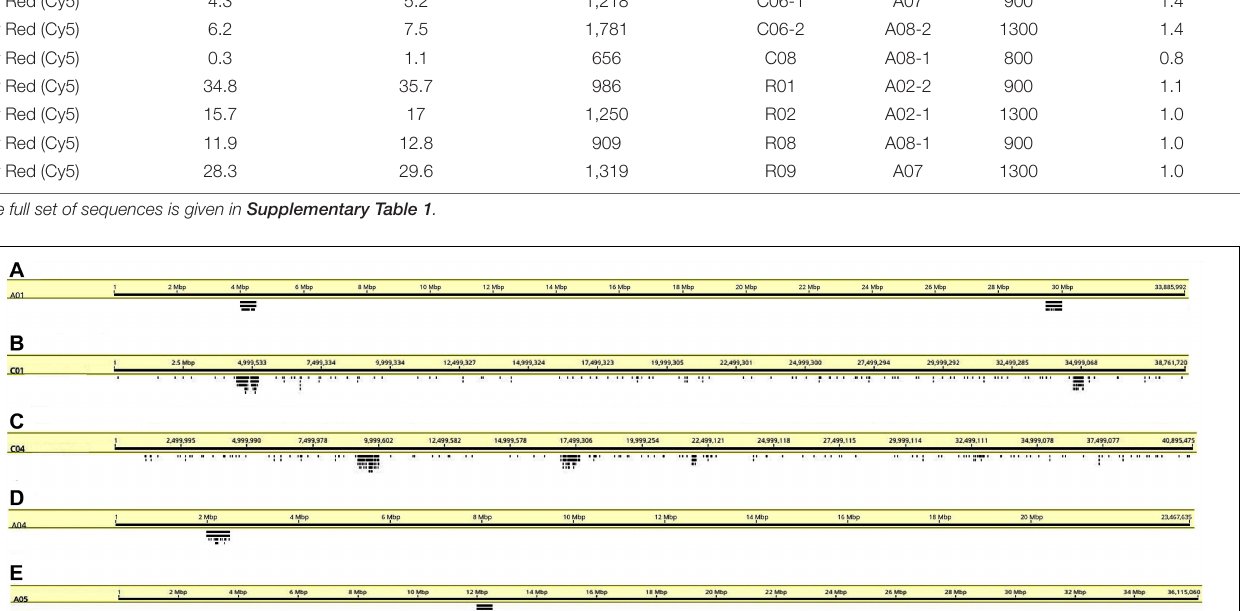
and regions of weaker and strong homology with (diagonal lines) ( Figures 3c,d ) with B. oleracea C03 and Raphanus